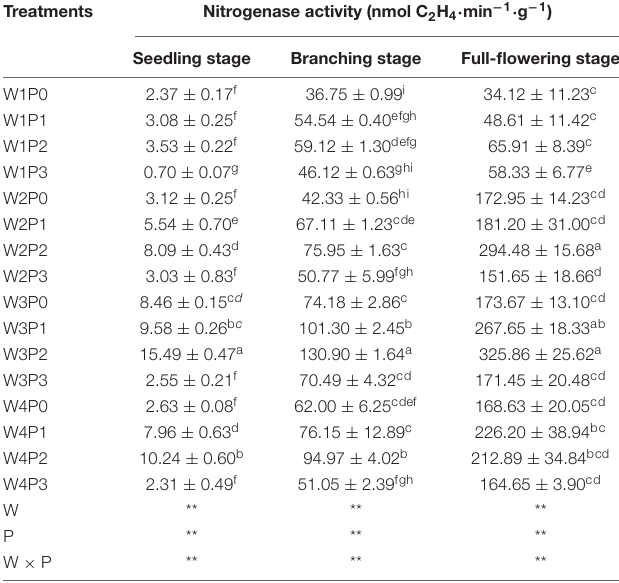
TABLE 2 | Response of nitrogenase activity of CMV to the synthesized effects of different soil moisture contents and levels of added phosphorus.